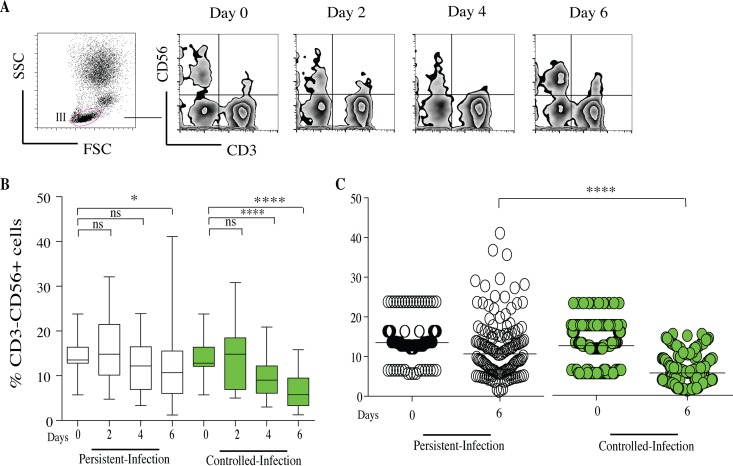
Characterization of CD56+ NK cells within Candida granuloma-like structures over time. Peripheral blood mononuclear and polymorphonuclear cells from 10 subjects were infected with 32 Candida clinical isolates for up to 6 days. The granuloma-like structures were collected from coculture plates at different time points and stained with a cocktail of fluorescence-conjugated antibodies specific to CD3 and CD56 lymphocytes. (A) Representative flow cytometry analysis showing SSC versus FSC plot of lymphocytes in section III. The cells were analyzed over time after gating on CD3 lymphocytes. Natural killer cells were gated as CD56+ from the CD3− population. (B) The proportions of CD56+ cells within granuloma-like structures are expressed as percentage of the total CD3− compartment. Box plots depict median, minimum, and maximum percentages of CD56+ cells in persistent-infection and controlled-infection granuloma-like structures. (C) Scatter plot of CD56+ NK cells proportions according to persistent- and controlled-infection status. *, P < 0.05; **, P < 0.001; ***, P < 0.0001; ****, P < 0.00001 (by one-way ANOVA with Tukey's multiple-comparison test) (n = 320).